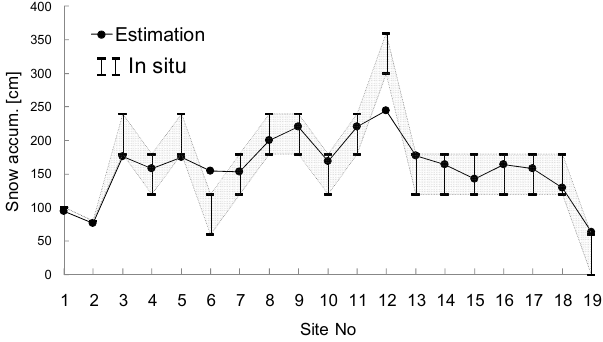
Figure 8. Comparison between estimated snow depth and in situ snow depth at 19 sites for an emissivity value of 0.95 for the Greenland ice sheet.